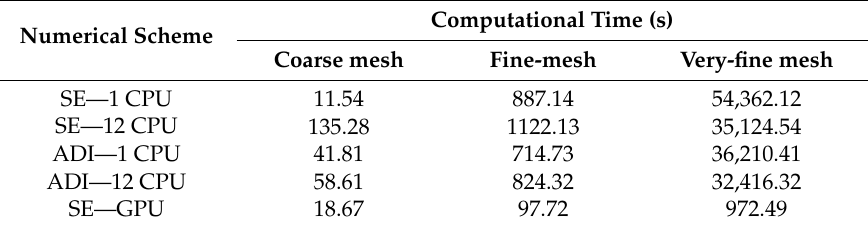
Table 1. Computation time for non-parallel and parallel solution